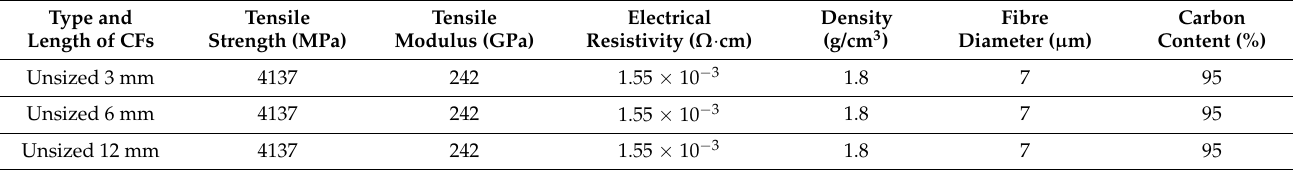
Table 4. Properties of the CF.